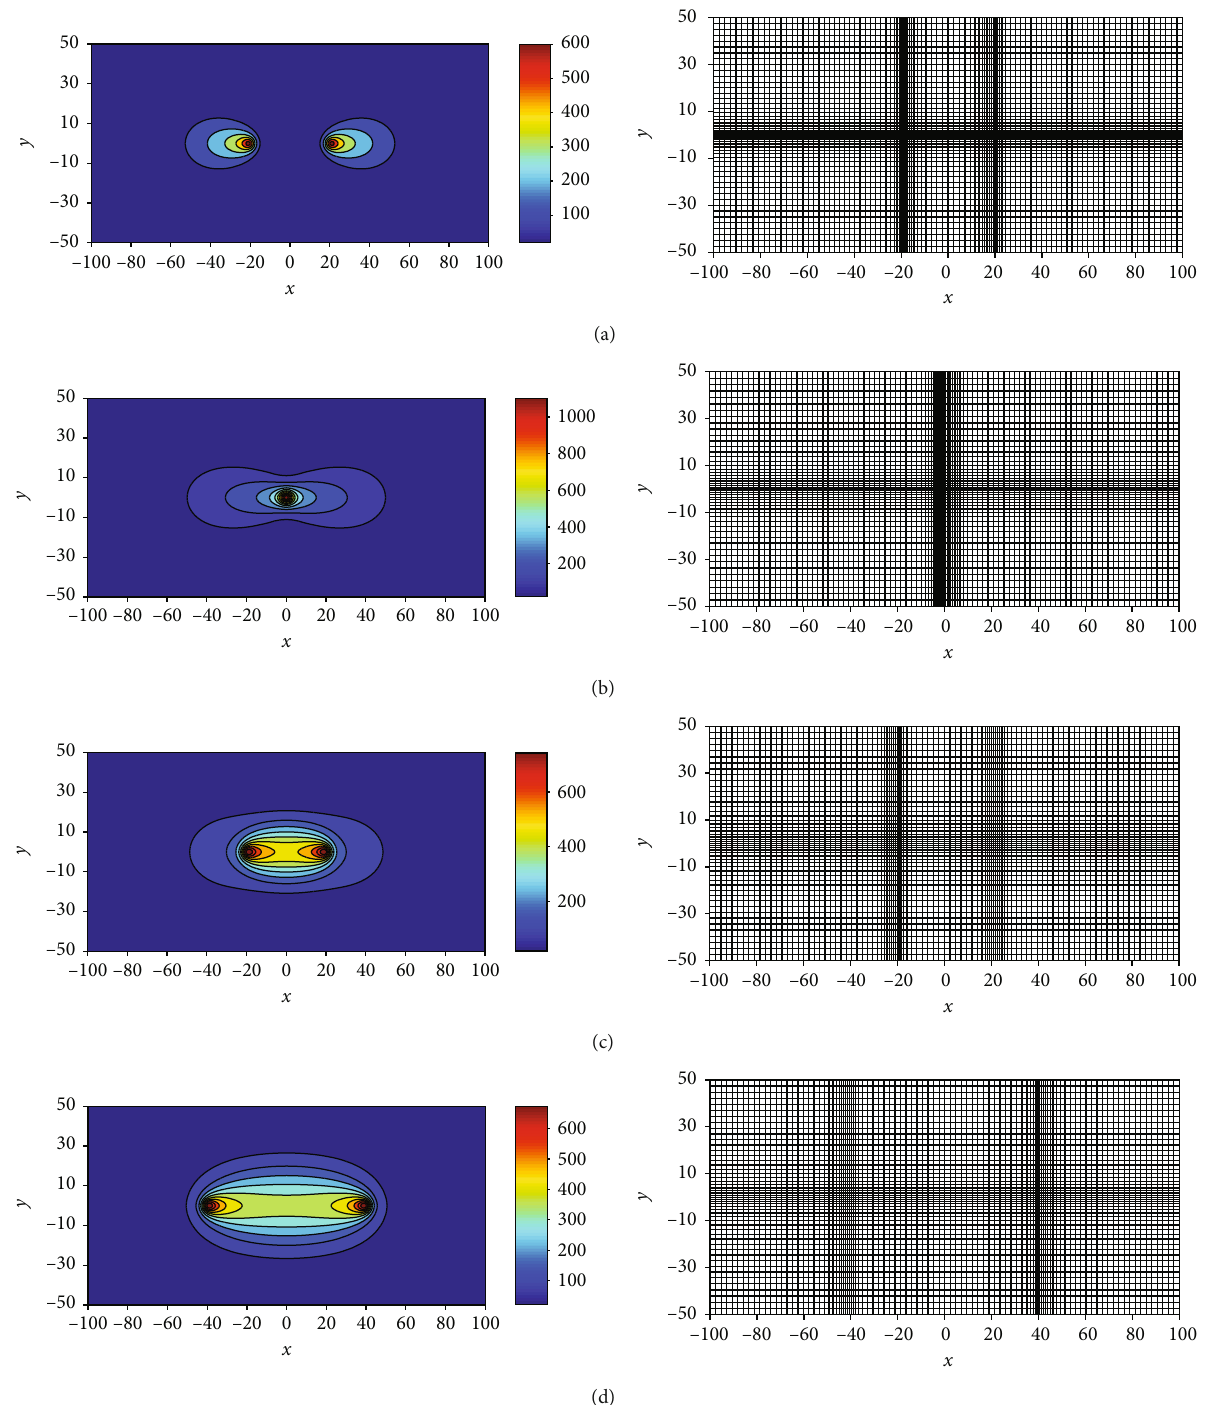
Figure 6: The transient temperature fi eld and the corresponding moving mesh at t = 15 (a), 25 , 35 , and 45 (d), respectively, for two heat sources moving along x -axis in opposite